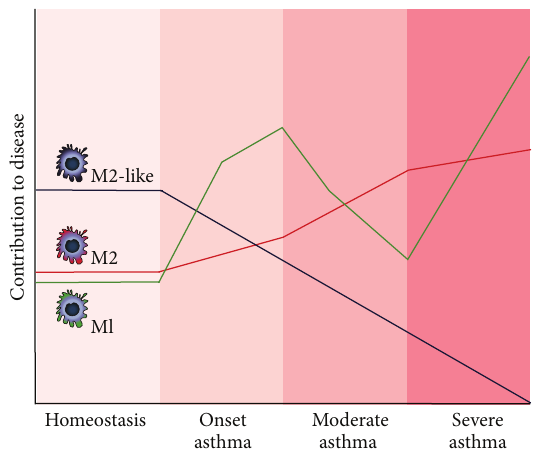
Figure 2: Schematic representation of the presence of M1, M2, and M2-like macrophages in lung tissue during homeostatic conditions, induction of asthma, and during moderate and severe